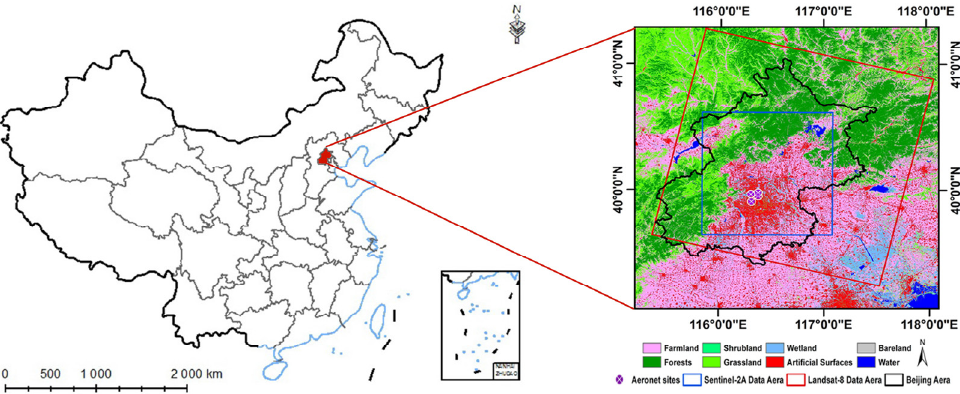
Figure 1. The location of the study area, coverage of satellite data, ground-based AERONET sites and the spatial distribution of land use cover types (the map of China is based on drawing review No. GS (2016) 1603 supervised by the Ministry of Natural Resources of the People’s Republic of China)